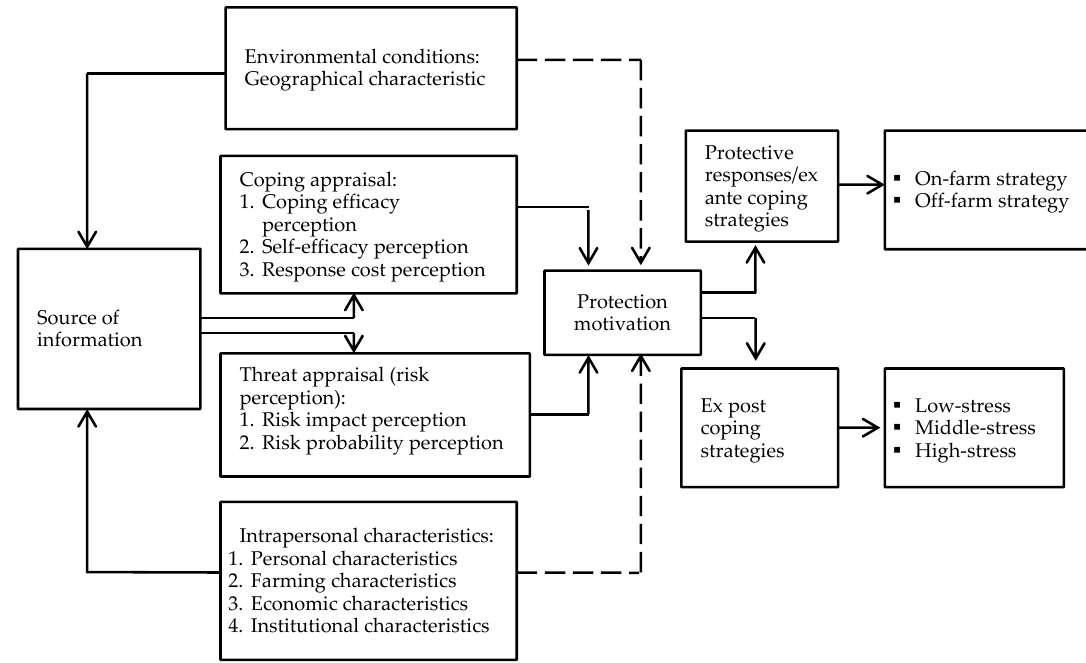
Figure 1. Framework used in the study. Modified from Rogers and Prentice-Dunn [27] (Figure 1, p. 114). Note: = the process of PMT; = predicted to directly influence protection motivation.